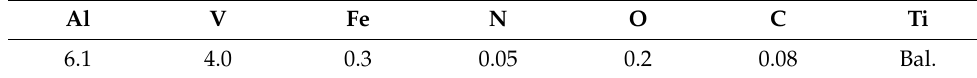
Figure 1. Ti-6Al-4V alloy ingot, where ST, TD and LD correspond to short transverse, transversal and longitudinal directions, respectively. Table 1. Chemical composition of the studied Ti-6Al-4V alloy (wt.%).